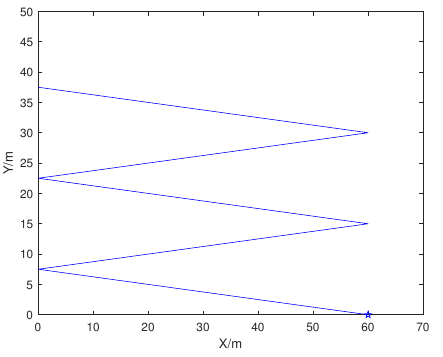
Figure 2. Sensor trajectory with five constant velocity segments and the initial position marked by a